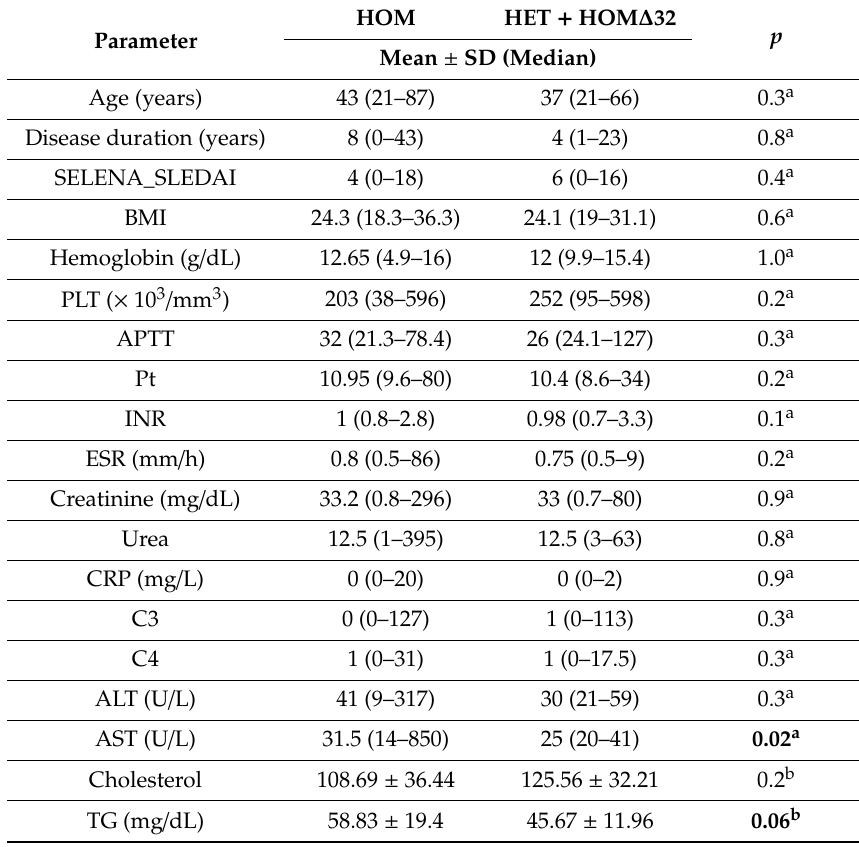
Table 7. Disease activity and laboratory variables in relation to CCR5 rs333, recessive